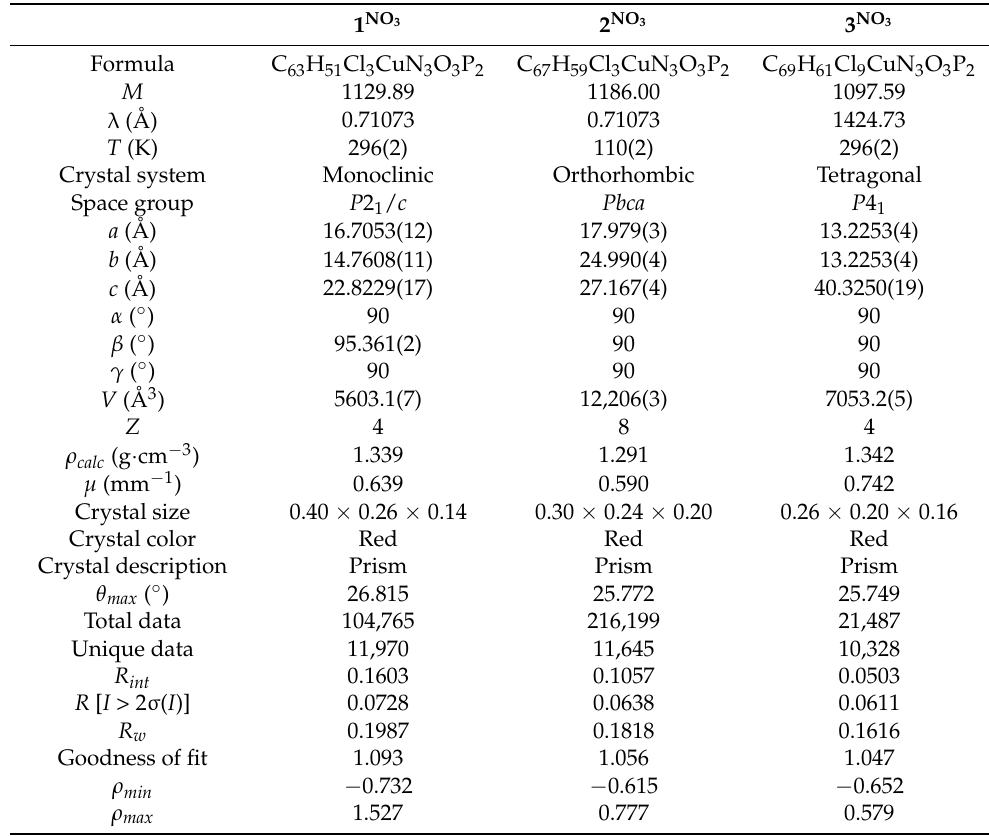
Table 4. Crystallographic data and details about refinement for structures 1 NO 3 , 2 NO 3 and 3 NO 3